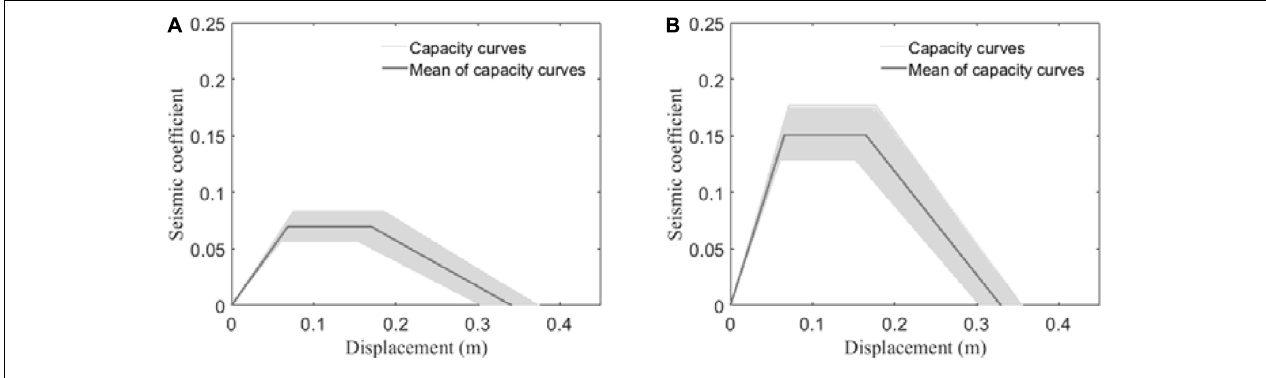
FIGURE 9 | Capacity curves associated with out-of-plane mechanisms: (A) one- and (B) two-story adobe dwellings.